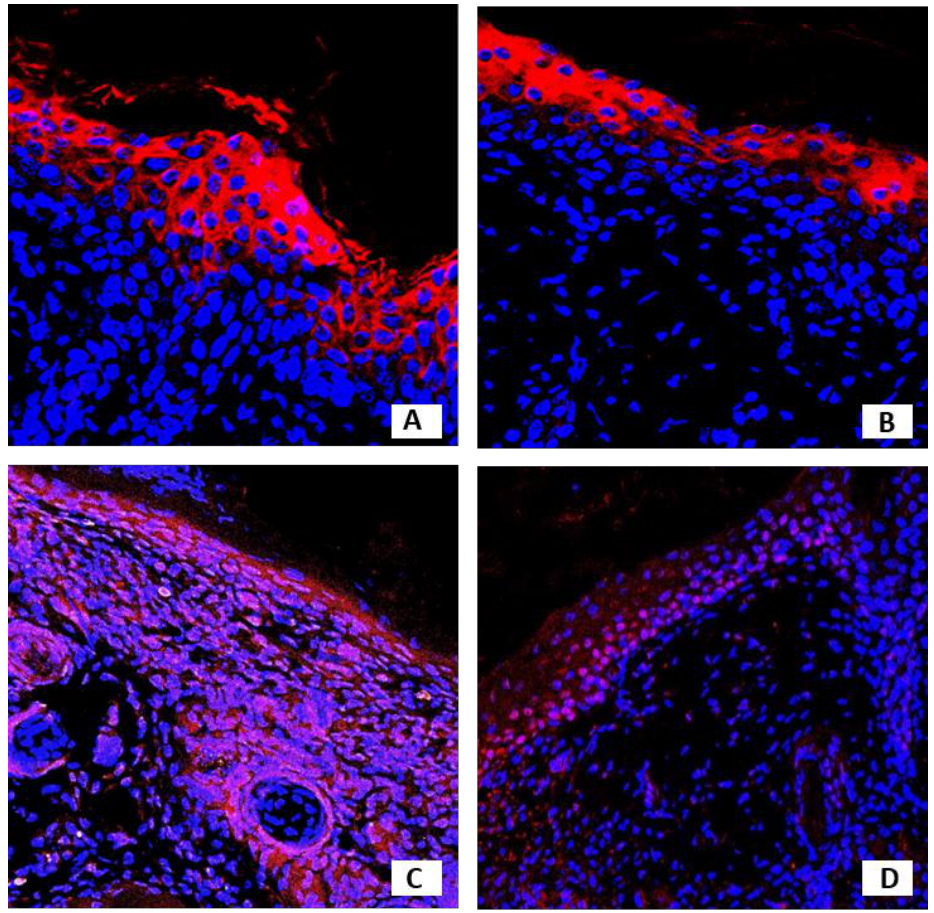
Figure 8. Confocal microscopy images of the newly formed epidermis. Grafted keratinocytes were isolated from skin preserved in anhydrous NaCl for 1 month. ( A ) Red-stained cells expressing CK10 (Alexa Fluor 633), nuclei stained blue (Hoechst), magnification 40 × . ( B ) CK 16 staining, magnification 40 × . ( C ) PCNA staining, magnification 20 × . ( D ) p63 staining, magnification 40 × .